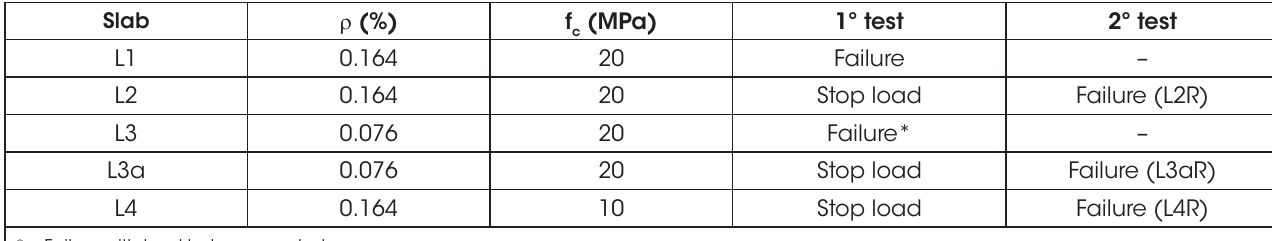
Main variables in the tested models